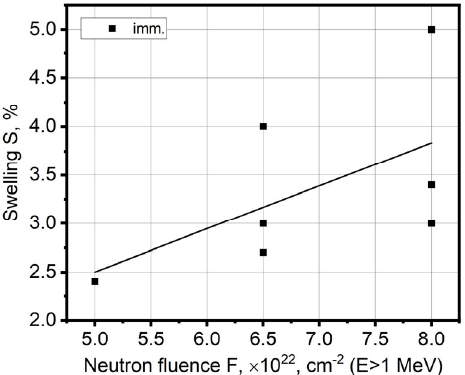
Figure 5. Dose dependence of swelling S of HE ‐ 56 beryllium grade, reactor SM ‐ 3, T irr = 200 °C, F = (0.3–6.5) ∙ 10 22 cm − 2 (E > 1 MeV) (imm.—immersion, dim.—dimension).